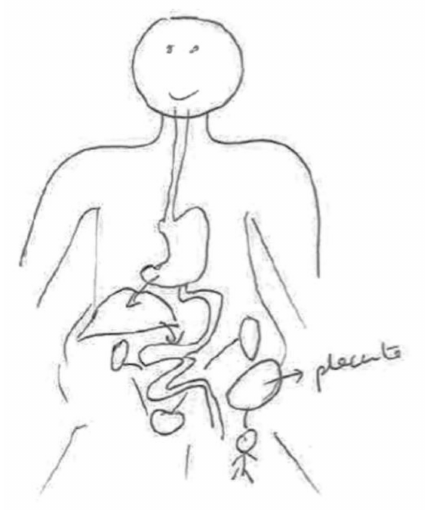
Figure 5. Pregnant, university education, pediatrician.